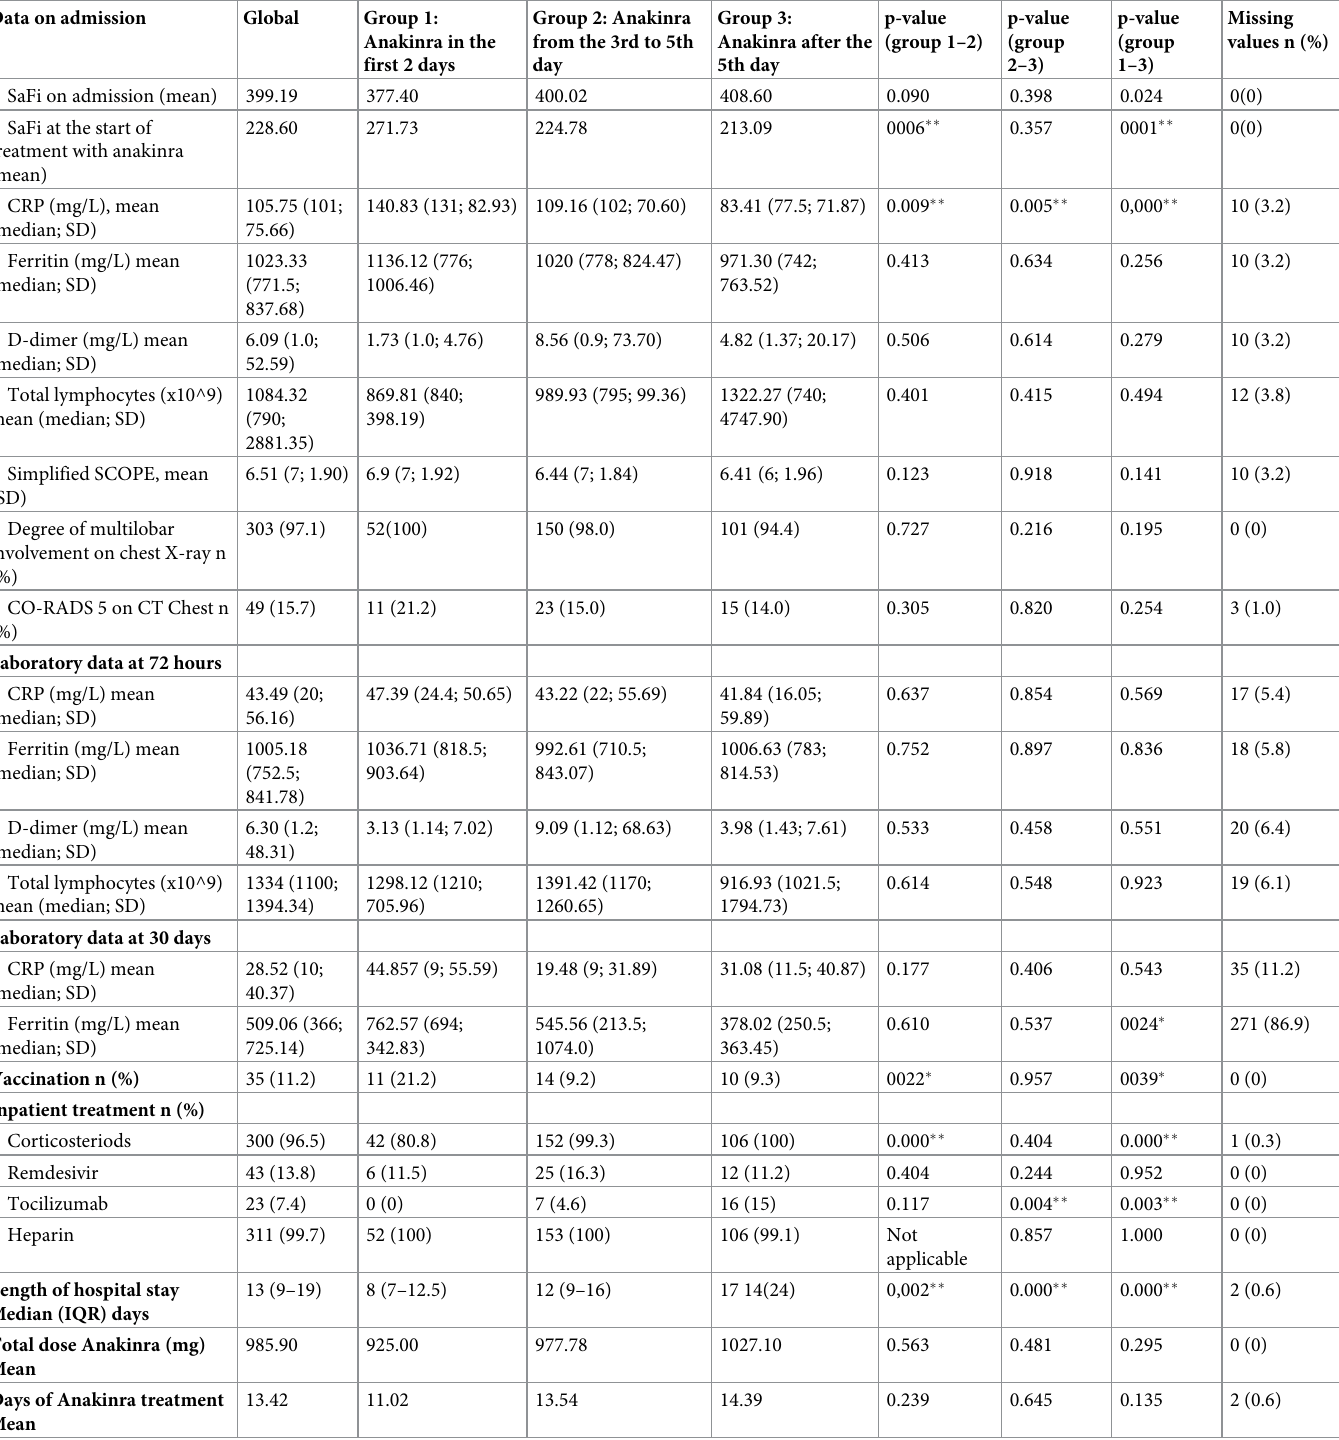
Table 3. SaFi, laboratory, radiology, vaccine status, and inpatient treatment